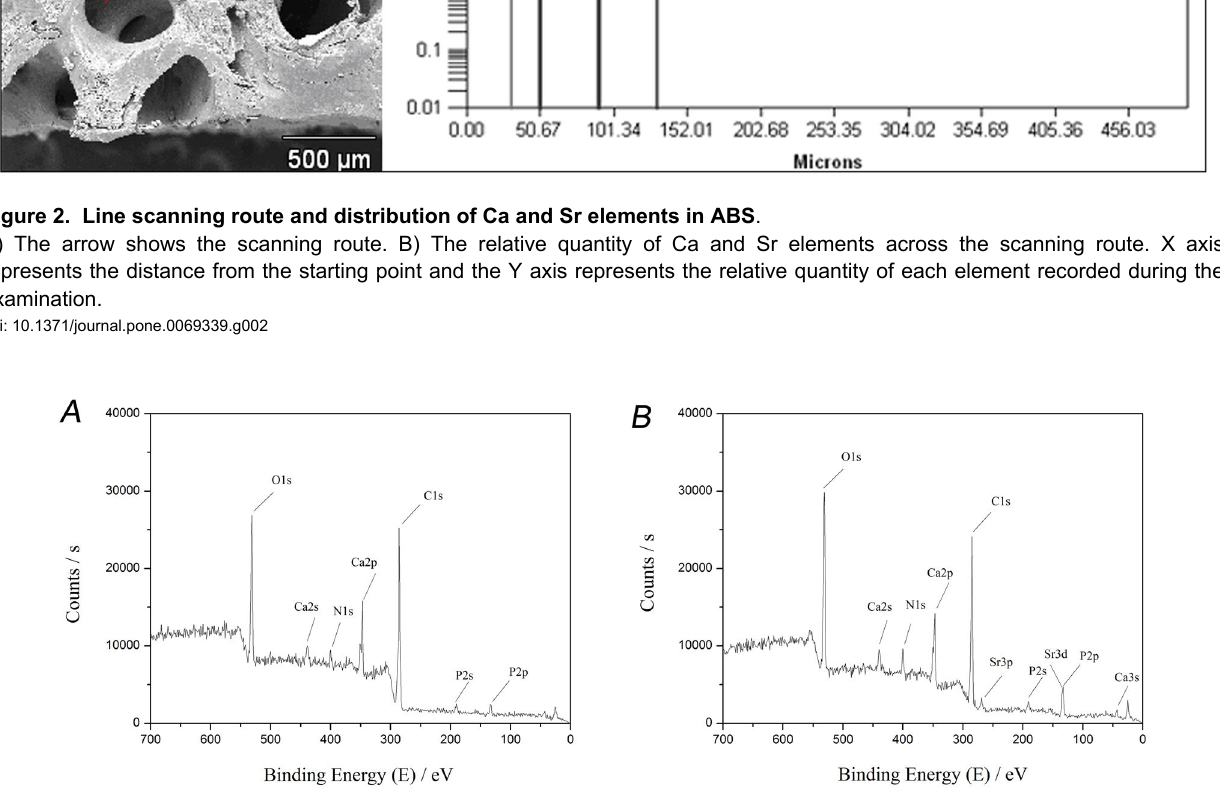
Figure 3. XPS analysis of bone powder:. A) XPS result before treatment. B) XPS result after treatment. The peak binding energy at 269.13 eV is from Sr3p3/2, at 133.52 eV is from Sr3d5/2, and at 347.08 eV is from